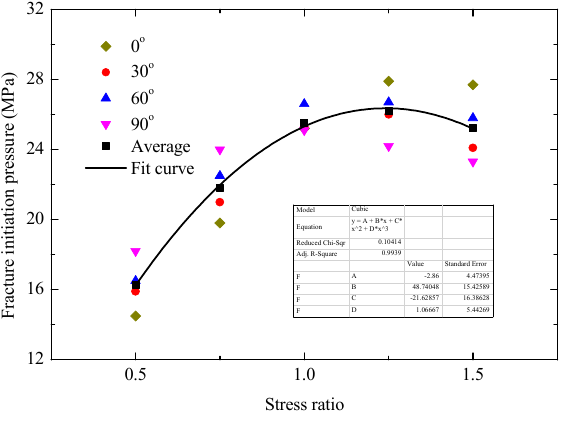
Energies 2018 , 11 , x FOR PEER REVIEW Figure 18. Change of fracture initiation pressure with stress ratio and bedding angle.